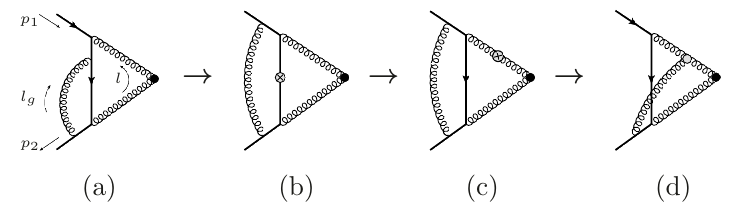
Figure 3 . The diagram transformation which moves the gauge boson vertex from the soft quark to the eikonal gauge boson line, as explained in the